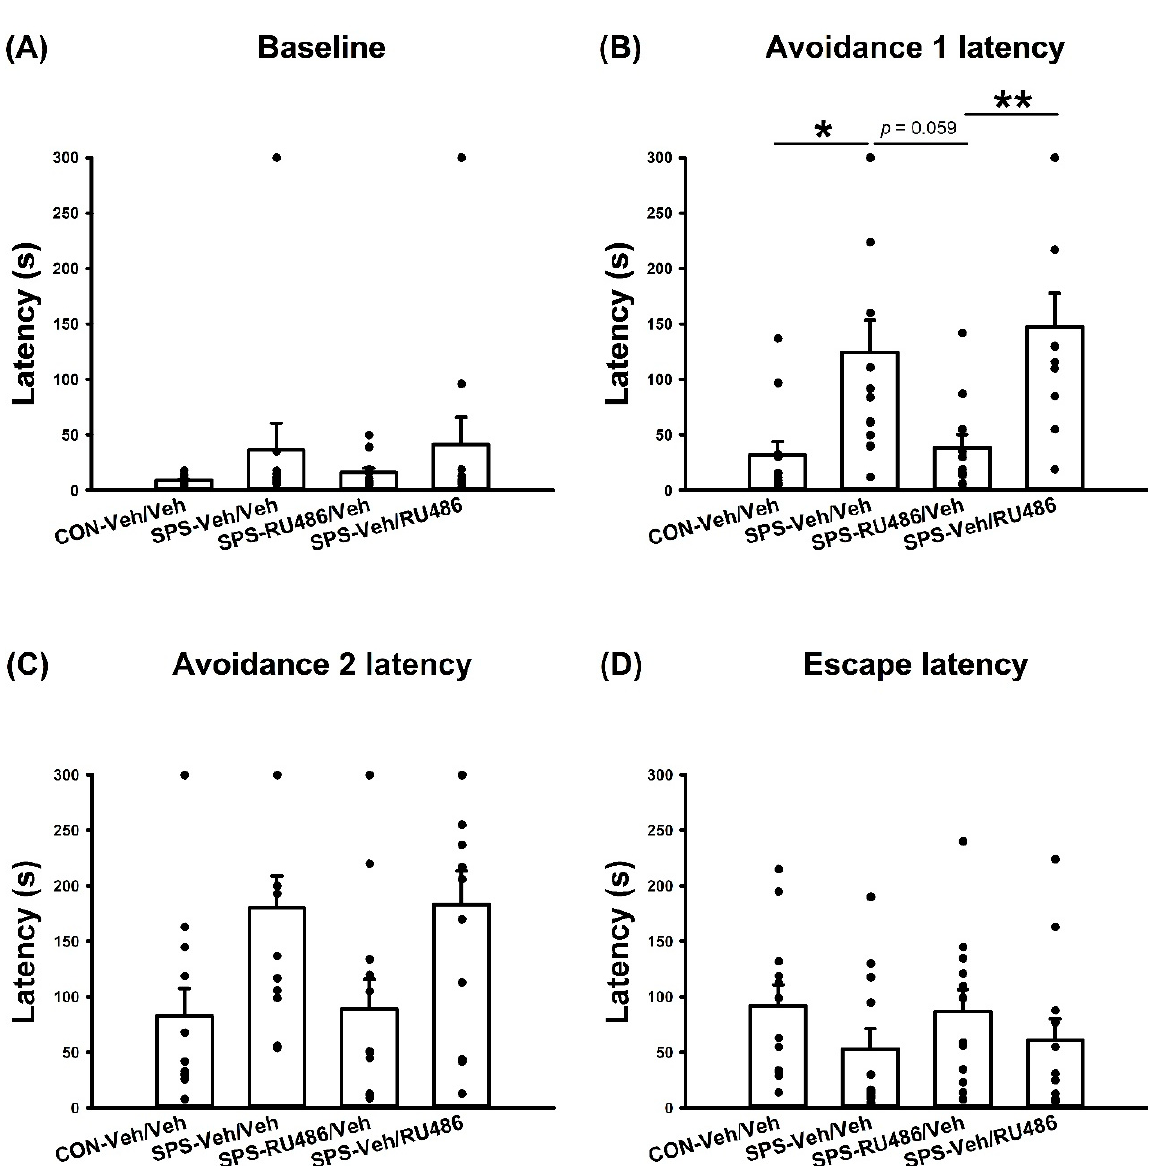
Figure 2. The preferences of the ( A ) Baseline ( B ) Avoidance 1 latency ( C ) Avoidance 2 latency and ( D ) Escape latency of ETM test after SPS paradigm and early/late RU486 intervention. The data represent the mean ± SEM. n = 12 for each group. Statistical analysis was employed with a one-way ANOVA followed by Bonferroni post hoc testing. * p < 0.05, ** p < 0.01.